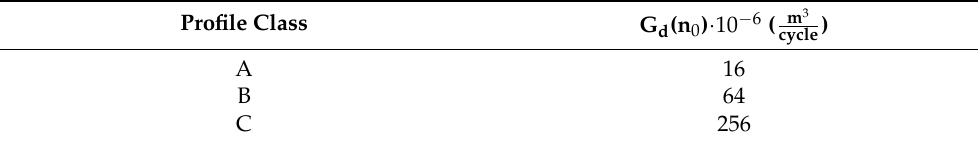
Table 5. Values of G d ( n 0 ) for the considered road roughness profiles according to ISO 8608.